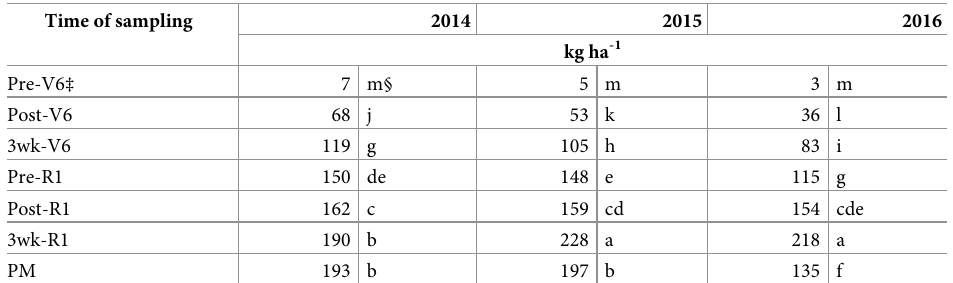
Meaningful differences between treatments started at the 3wk-R1 sampling and continued until the last sampling. During the 3wk-R1 to PM sampling, tissue N uptake was greater when 100% of the recommended rate was applied and decreased as N application rate decreased, especially at the PM sampling. In 2015, although differences started at the Post-V6 sampling, meaningful differences started at the Pre-R1 and remained until the PM sampling. There was a trend for tissue N uptake to be greater when N application was split into two or three applica- tions during the growing season compared with single application. For example, tissue N Table 8. Year × time of sampling for maize tissue N uptake at Lamberton